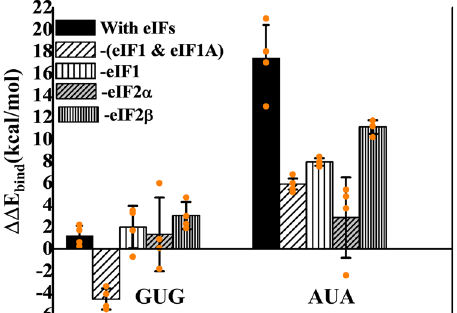
Fig. 1 Schematic representation of the simulation sphere. a The ribosomal 48 S PIC in open state (PDB ID: 6GSM) is shown in surface representation. The simulation sphere around P site is encircled. b A zoomed in view of the simulation sphere. The portions of initiation factors eIF1 (indigo), eIF1A (violet), eIF2 α (purple), and eIF2 β (blue), the initiator tRNA (green) and mRNA (pink) are shown in cartoon representation. The AUG codon at the P site of mRNA was used for calculating the binding energy for cognate start codon:anticodon (AUG:UAC) interactions. The codon at P site was mutated to different codons to calculate the binding energy for respective mutant codon:anticodon interactions. The relative binding energies were calculated with respect to the AUG start codon.